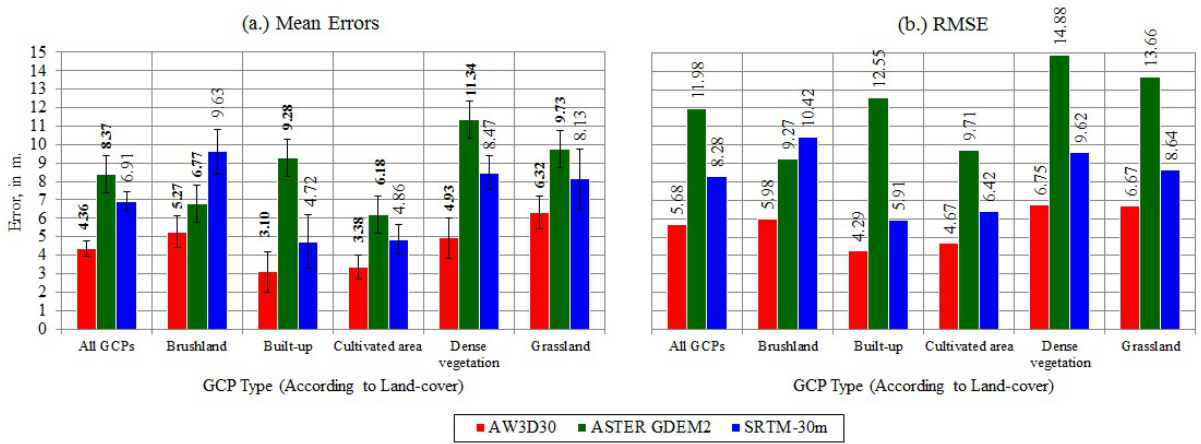
Figure 4: Mean errors and RMSE of DEMs (indicated by the numerical values), plotted side-by-side of each other for easier comparison. Error bars represent 95% confidence intervals of the